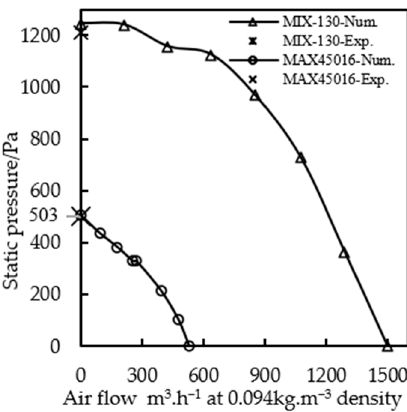
Figure 13. Performance comparison of fans in stratospheric conditions.